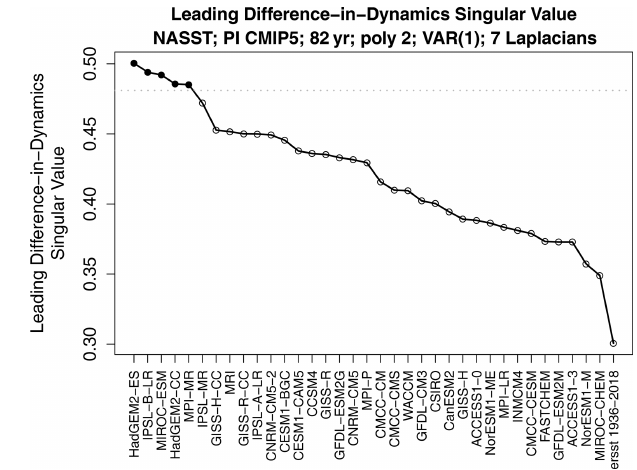
Figure 6. The leading difference-in-dynamics singular value for each CMIP5 model. The 5% significance threshold under H 1 is shown as the dotted horizontal line. Significant and insignificant singular values under H 1 are indicated by filled and open circles,